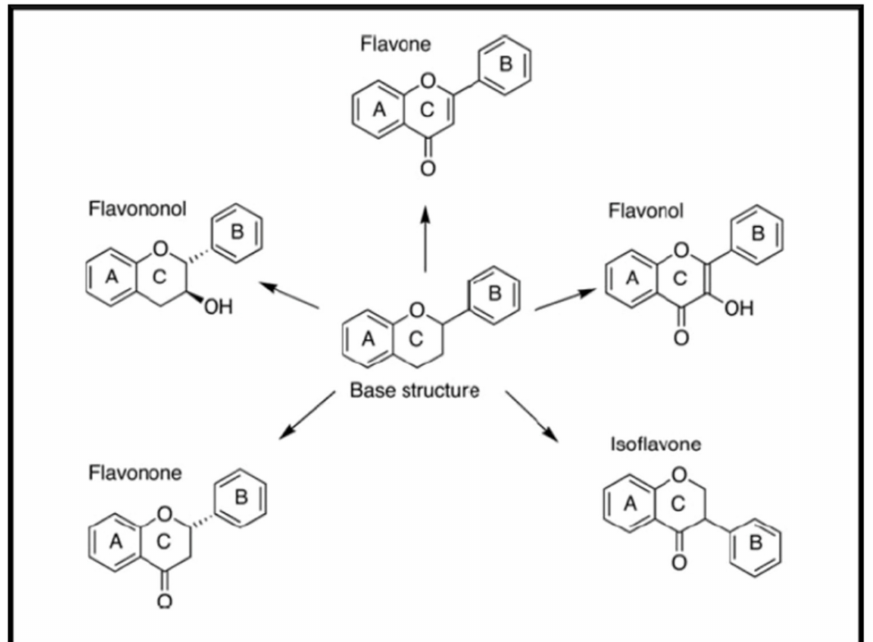
Figure 4. Structure of